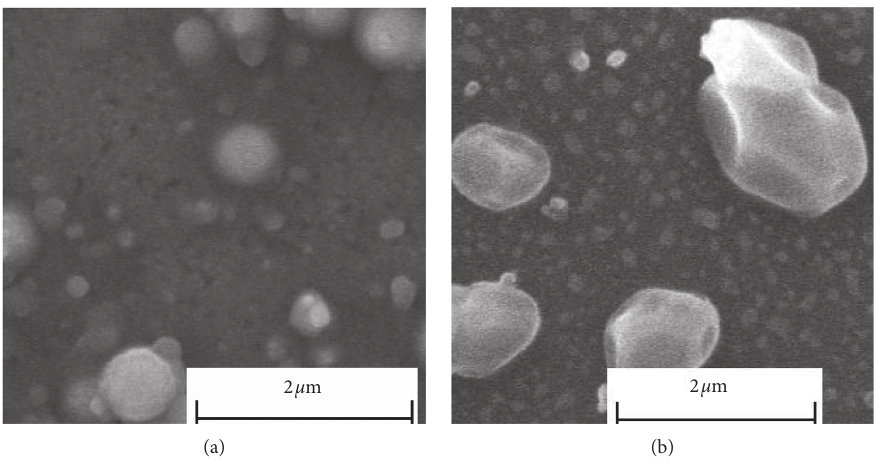
Figure 2: SEM images of cobalt sulfide thin films deposited at (a) 2hrs and (b)